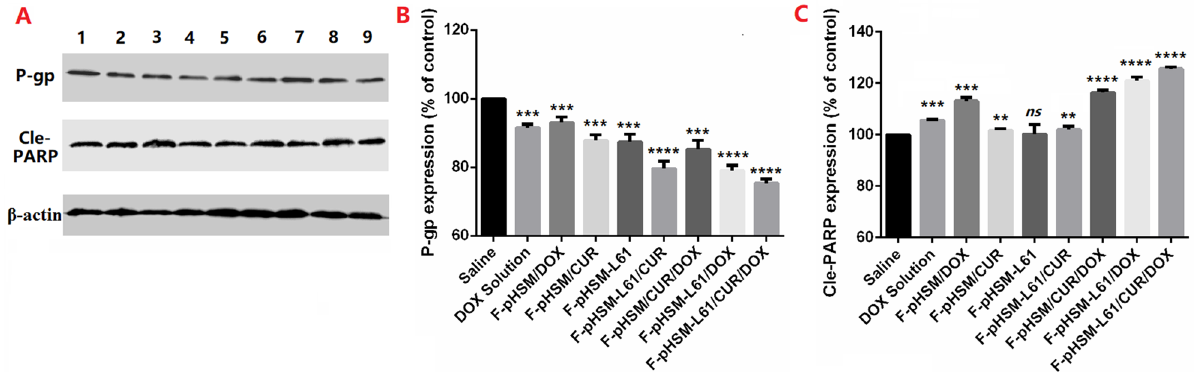
Figure 18. Expression of P-gp and Cle-PARP in tumor tissue from mice after treatment with different formulations ( A ). Quantitative analysis of the expression of P-gp ( B ) and Cle-PARP ( C ) in tumor tissue from mice after treatment with different formulations: 1. Saline; 2. DOX solution; 3. F-pHSM/DOX; 4. F-pHSM/CUR; 5. F-pHSM-L61; 6. F-pHSM-L61/CUR; 7. F-pHSM/CUR/DOX; 8. F-pHSM-L61/DOX; 9. F-pHSM-L61/CUR/ DOX. Statistical significance was defined as *P <0.05, **P <0.01, ***P <0.001 and ****P <0.0001. One data-point for F-pHSM-L61/CUR was omitted, as it was considered an outlier (more than 3 standard